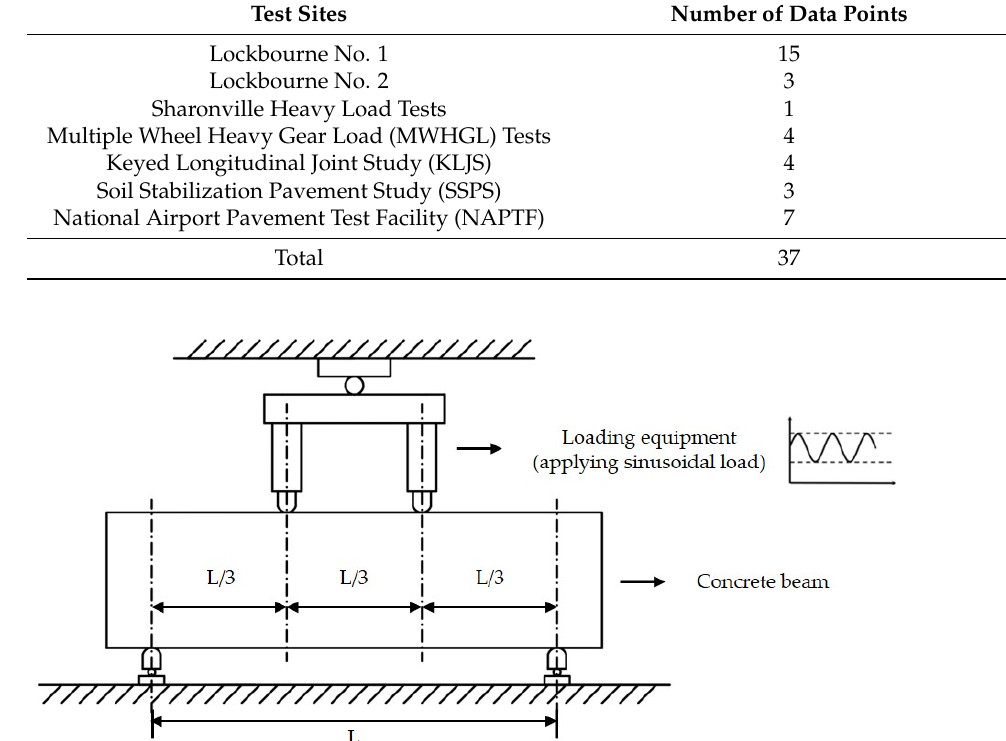
Figure 4. The schematic diagram of concrete beam fatigue test.